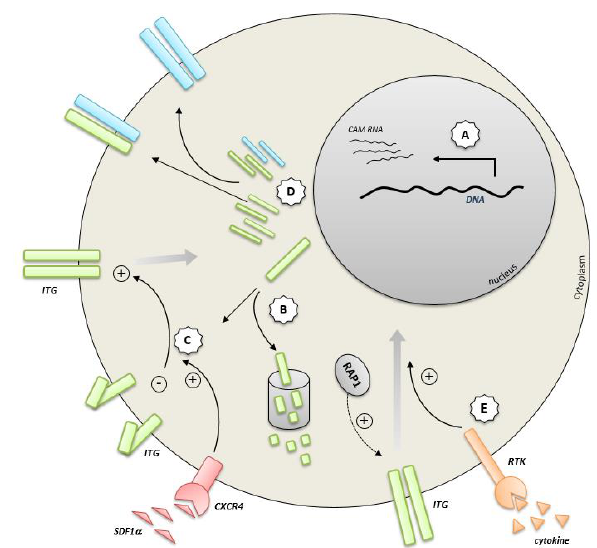
Figure 4. Described and hypothesized mechanisms of oncogenic interference with adhesion molecule function. ( A ) Transcriptional deregulation of adhesion molecule expression by aberrant transcription factors (e.g., RUNX1/ETO [100] or TAL1) [51]. ( B ) Interference with cellular destruction of adhesion molecules through proteasomal degradation. ( C ) Activation of integrin receptors by co-receptors (e.g., the SDF1α/CXCR4/VLA4 axis ) and modulators thereof (e.g., CEBPα ) [89]. ( D ) Interference with the composition of the adhesion molecule complex. ( E ) Superactivation of pre-activated adhesion molecule signaling pathways (e.g., by receptor tyrosine kinases) [73]. ITG, integrin; RTK, receptor tyrosine kinase.